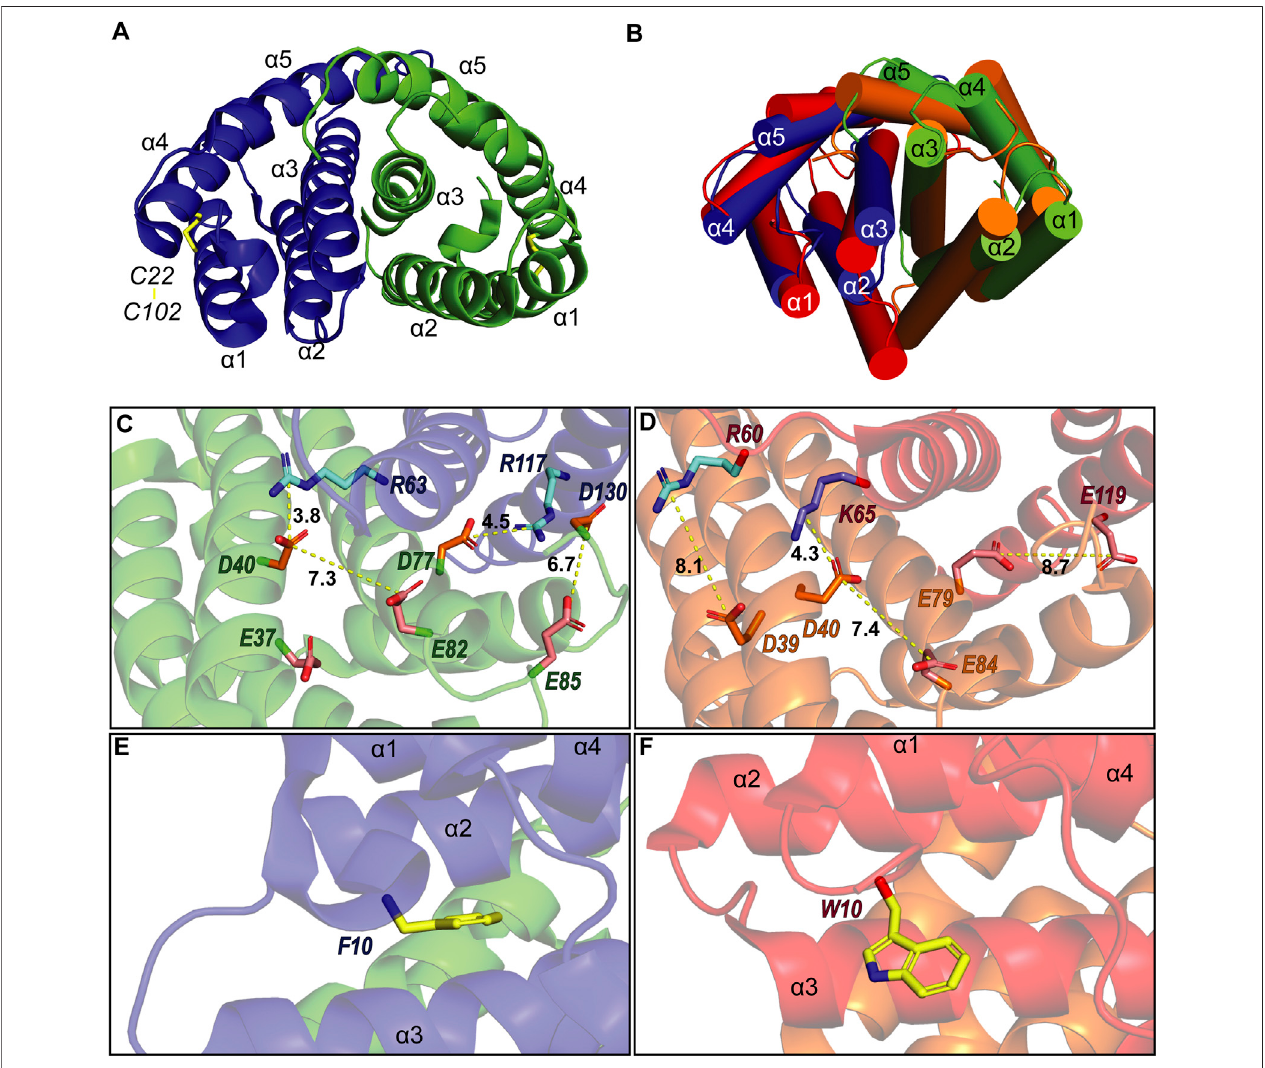
FIGURE 3 | (A) Structure of A. argentata TuSp NT dimer (PDB ID 6TV5) with the two subunits shown in blue and green and their helices numbered. The intramolecular disul fi de is highlighted with yellow stick representation. (B) Superposition of the structures of TuSp NT and E. australis MaSp NT (PDB ID 2LTH, red) dimers. α -helices are shown as cylinders. (C) and (D) shows charge interactions between residues on the subunit interface for A. argentata TuSp (C) and E. australis MaSp (D) NT, respectively. Aspartic acid side chains are colored orange, glutamic acids are pink, arginines are cyan and lysines are blue. (E) and (F) show the orientation of F10/W10 side chain within each structure